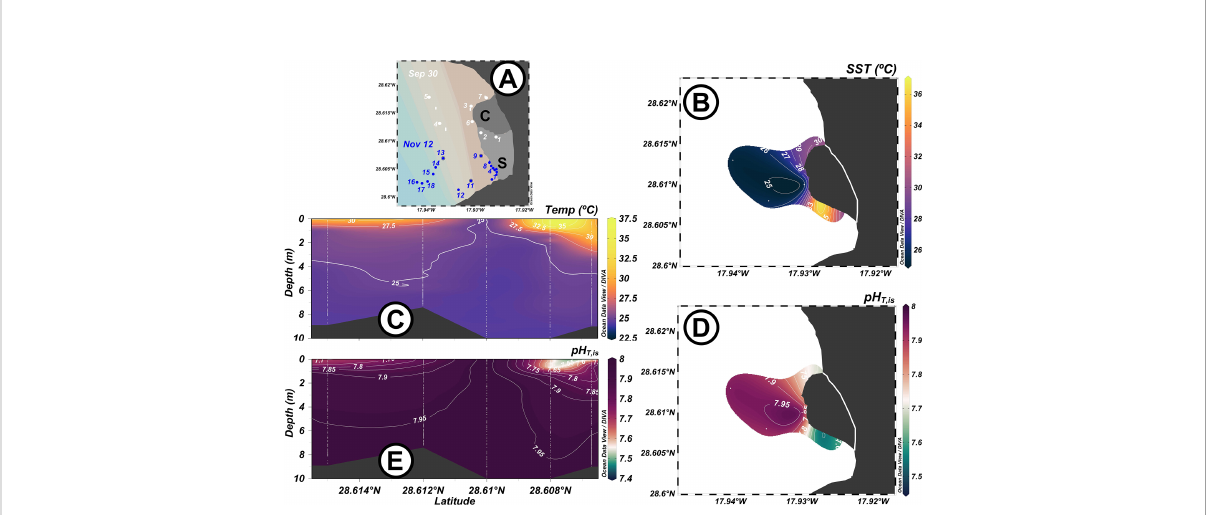
FIGURE 4 (A) Map of the sampling stations at the south delta covering original station C (Figure 1C) visited during September 30th (white dots). Sampling stations during November 12th (dark blue dots) are also included. Surface (B, D) and vertical (C, E) plots of temperature (Temp, B, C ) and pH T,is (D, E) along the fi rst formed